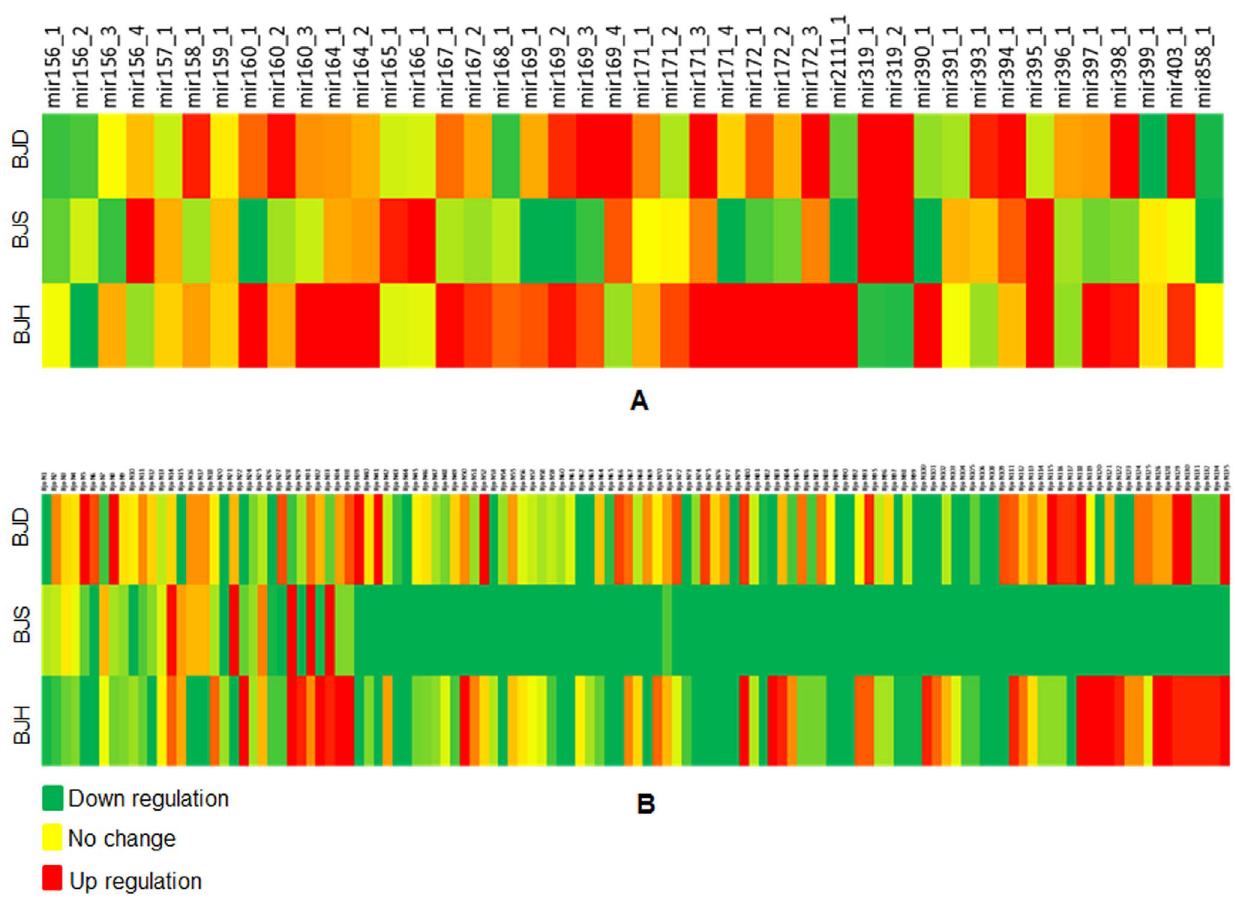
Figure 1. The digital expression values obtained through high-throughput sequencing were normalized using TPM (transcripts per million) method and used to calculate digital expression fold change [Log 2 (abiotic stress treated sample/control sample)] in high temperature treated (BJH), salinity stress treated (BJS) and drought stress treated (BJD) B.juncea seedlings library with respect to untreated seedlings library. Thus deduced digital expression fold change is presented as heat map for conserved (A) and novel (B) miRNA sequences.